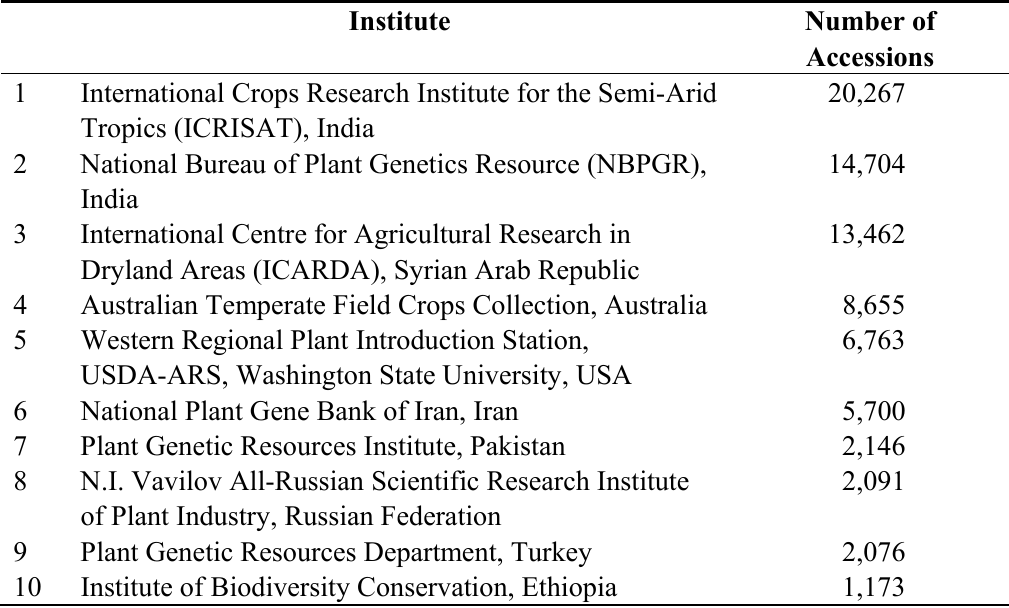
Table 1. Chickpea germplasm held at global research institutes